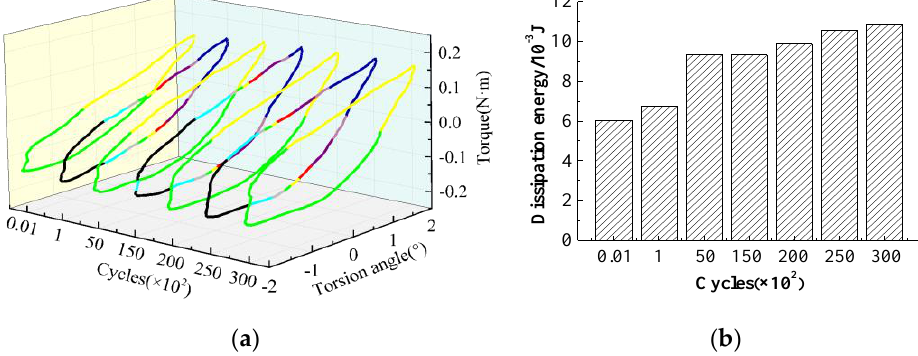
Figure 8. Evolutions and dissipation energy of torque versus torsion angle. ( a ) Evolution of the hysteresis loop. ( b ) Dissipation energy at loading cycles 20,000.